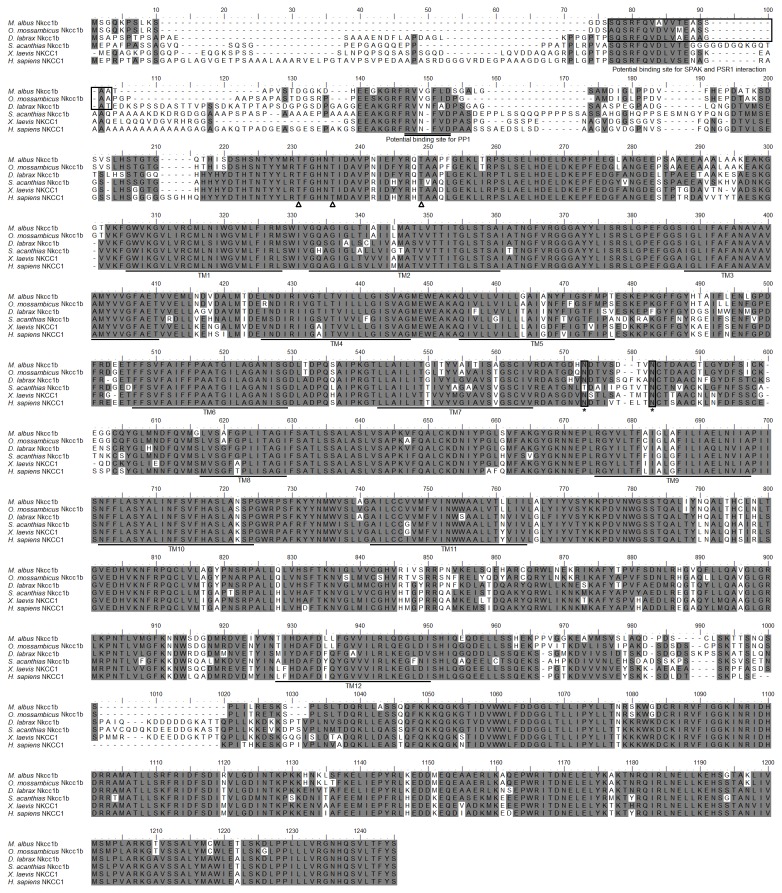
Molecular characterization of Na+:K+:2Cl- cotransporter 1b (Nkcc1b) from the brain of

Monopterus

albus
.A multiple sequence alignment of the Nkcc1b from the brain of M. albus with five other known Nkcc1/NKCC1 amino acid sequences from other animal species with Genbank accession numbers:

Oreochromis

mossambicus
 (AAR97732.1),

Dicentrarchus

labrax
 (ABB84251.1),

Squalus

acanthias
 (AAB60617.1), Xenopus laevis (ABN05233.1) and Homo sapiens (P55011.1). Shaded residues denote identical residues. Ste20-related proline-alanine-rich-kinase (SPAK) interaction site is indicated with boxes and protein phosphatase 1 (PP1) interaction site is double-underlined. Predicted phosphorylation sites are indicated by open triangles while potential N-glycosylation sites are indicated with boxes and ‘*’. The predicted transmembrane domains (TM) are underlined. The transmembrane domains of Nkcc1b of M. albus were predicted using MEMSATS & MEMSAT-SVA provided by PSIPRED protein structure prediction server.